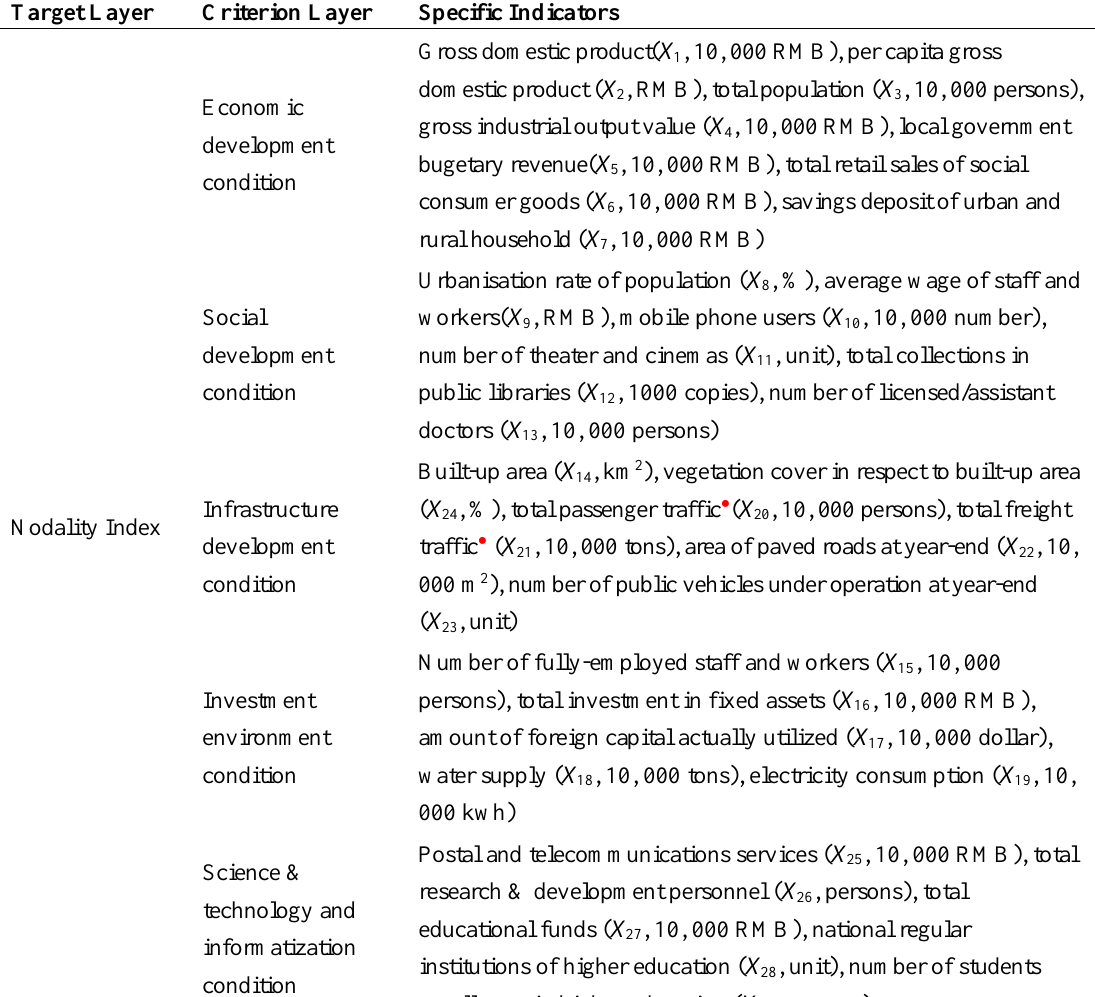
Table 1. The indicator system of nodality